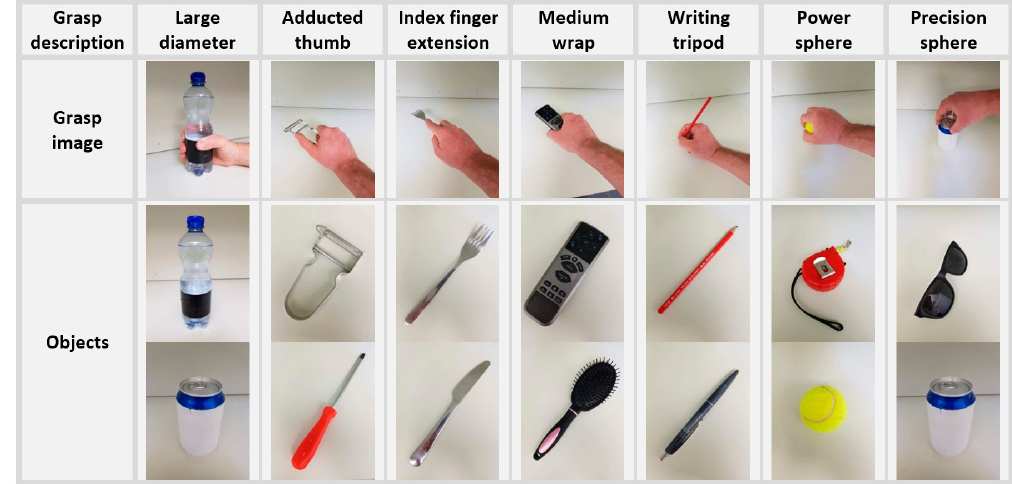
Figure 2. Seven daily-life grasps used in NinaPro DB6 (top row), each one employed for the grasping of two di ff erent objects (lower rows).